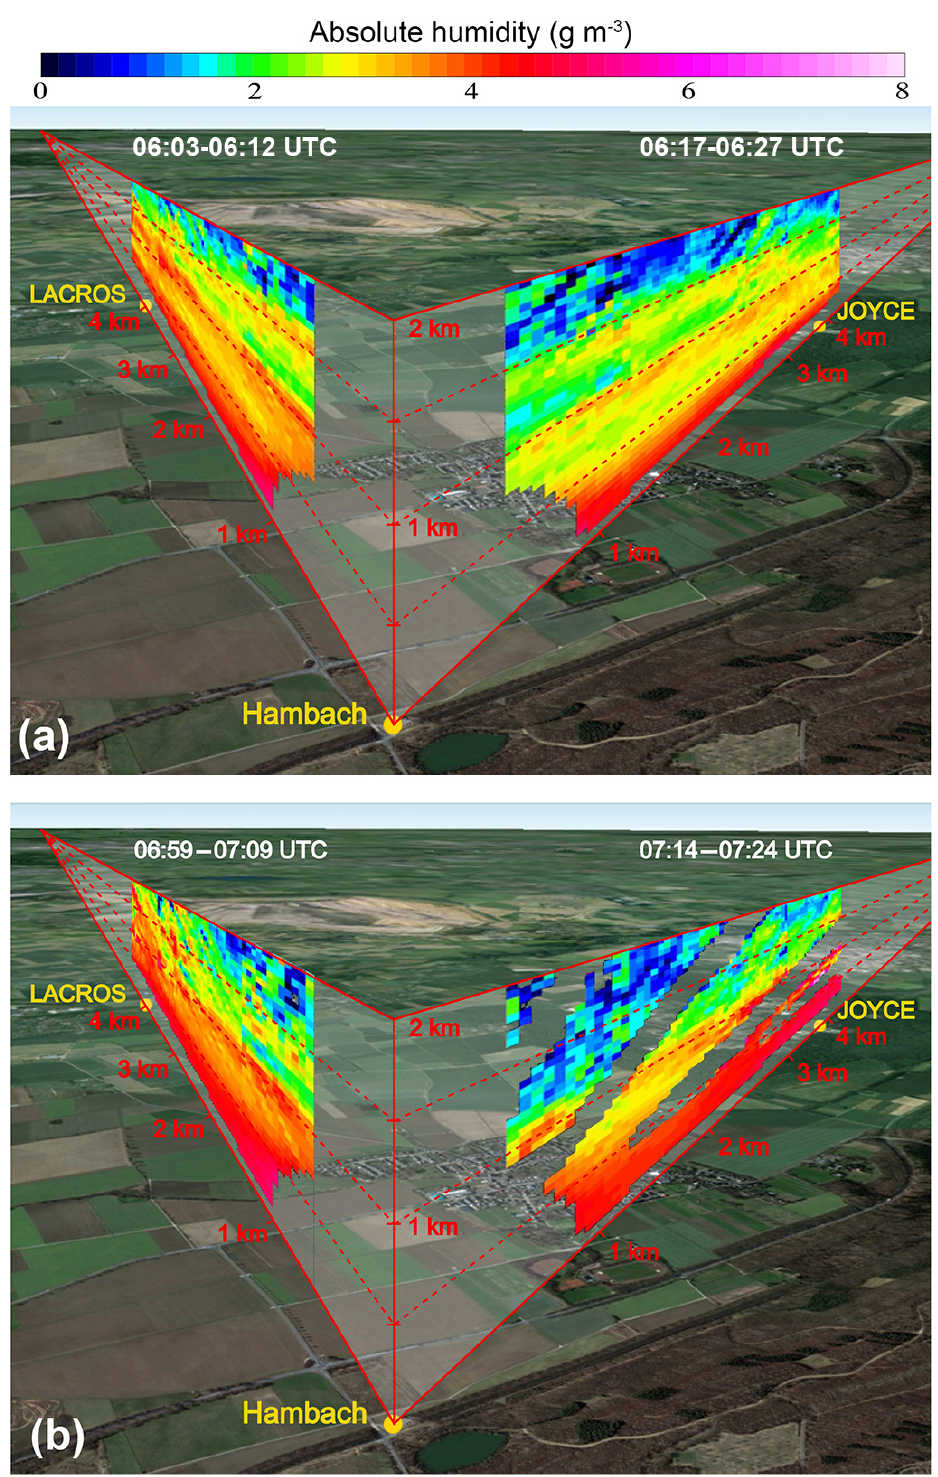
Figure 6. 3-D illustration of the WV field in the HOPE domain. The scanning measurements were performed towards LACROS and JOYCE on IOP 4 on 20 April 2013 between (a) 06:03 and 06:27 UTC and (b) 06:59 and 07:24 UTC. The UHOH DIAL system was located at the Hambach site and scanned towards the other supersites LACROS and JOYCE. The distances to the other sites were around 4km. In (b) the gaps in the data occur from clouds at the top of the CBL. Background image from Google